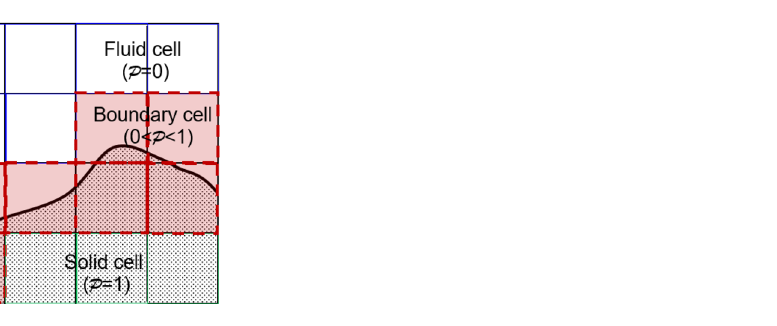
Figure 2. Illustration of the cell-based lattice involving solid ( P boundary (0 < P < 1, red)